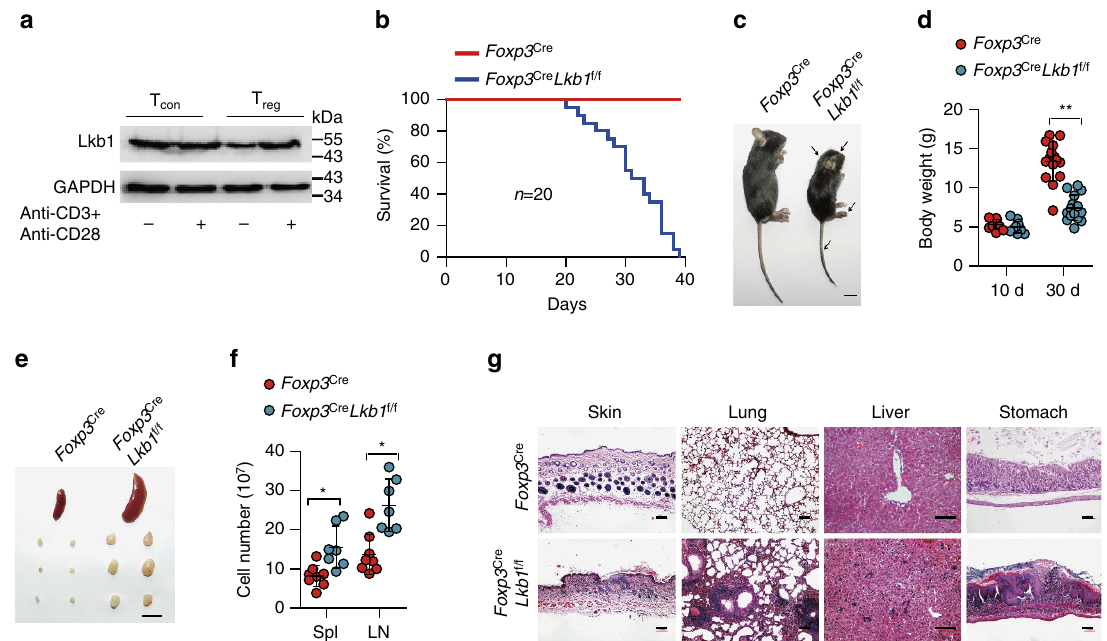
Figure 1 | T reg cell-specific deletion of Lkb1 leads to a fatal autoimmune disease. ( a ) Lkb1 proteins in CD4 þ YFP (cid:2) conventional Tcells and CD4 þ YFP þ T reg cells untreated or stimulated in plates coated with anti-CD3 and anti-CD28 in the presence of IL-2 for 24h determined by western blot. ( b ) Survival of Foxp3 Cre and Foxp3 Cre Lkb1 f/f mice ( n ¼ 20). ( c ) A representative appearance of 30-day-old Foxp3 Cre and Foxp3 Cre Lkb1 f/f mice (scale bar, 1cm). ( d ) Body weight of Foxp3 Cre and Foxp3 Cre Lkb1 f/f male mice of different ages ( n ¼ 10–15). ( e ) A representative picture of spleen and lymph nodes from 30-day-old Foxp3 Cre and Foxp3 Cre Lkb1 f/f mice. (scale bar, 1cm). ( f ) Total cell numbers in spleen (Spl) and lymph nodes (LNs) of Foxp3 Cre and Foxp3 Cre Lkb1 f/f mice ( n ¼ 7–8). ( g ) Representative haematoxylin and eosin-stained skin, lung, liver and stomach sections from Foxp3 Cre and Foxp3 Cre Lkb1 f/f mice (scale bar, 100 m m). All mice analysed were 28–30 days old, unless otherwise specified. Log-rank survival curve was used for survival analysis in b , and two-way analysis of variance (ANOVA) was used for statistical analyses in d , f (* P o 0.05, ** P o 0.01, **** P o 0.0001); error bars represent s.d.; all data are representative of at least three independent